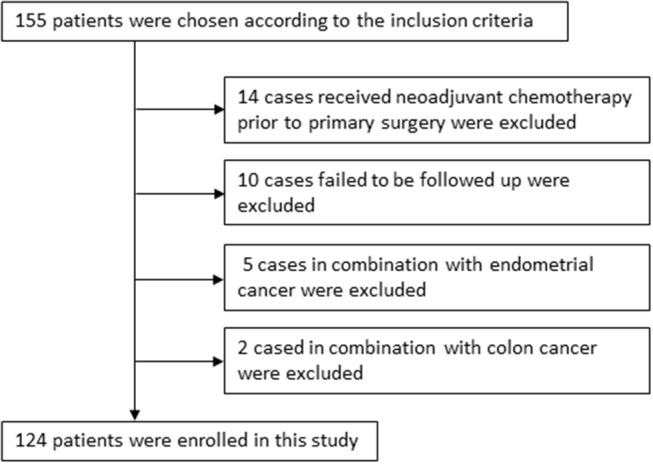
124 epithelial ovarian cancer patients with cisplatin resistant recurrence enrolled in this study were described graphically.